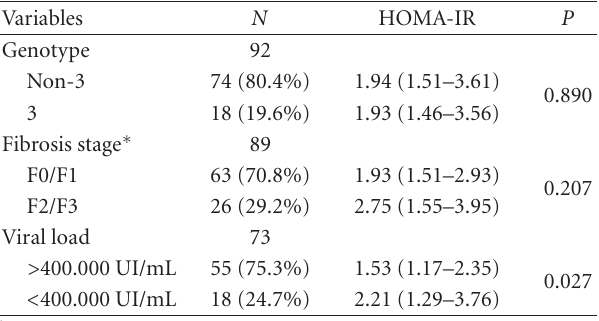
Table 3: HOMA-IR according to viral characteristics of patients with chronic hepatitis C.